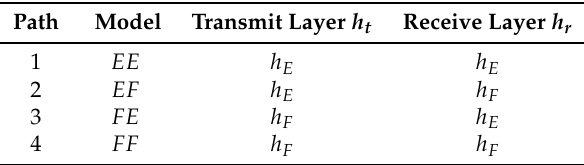
Figure 2. Radar signal propagates through different ionospheric layers. Table 1. Signal propagation